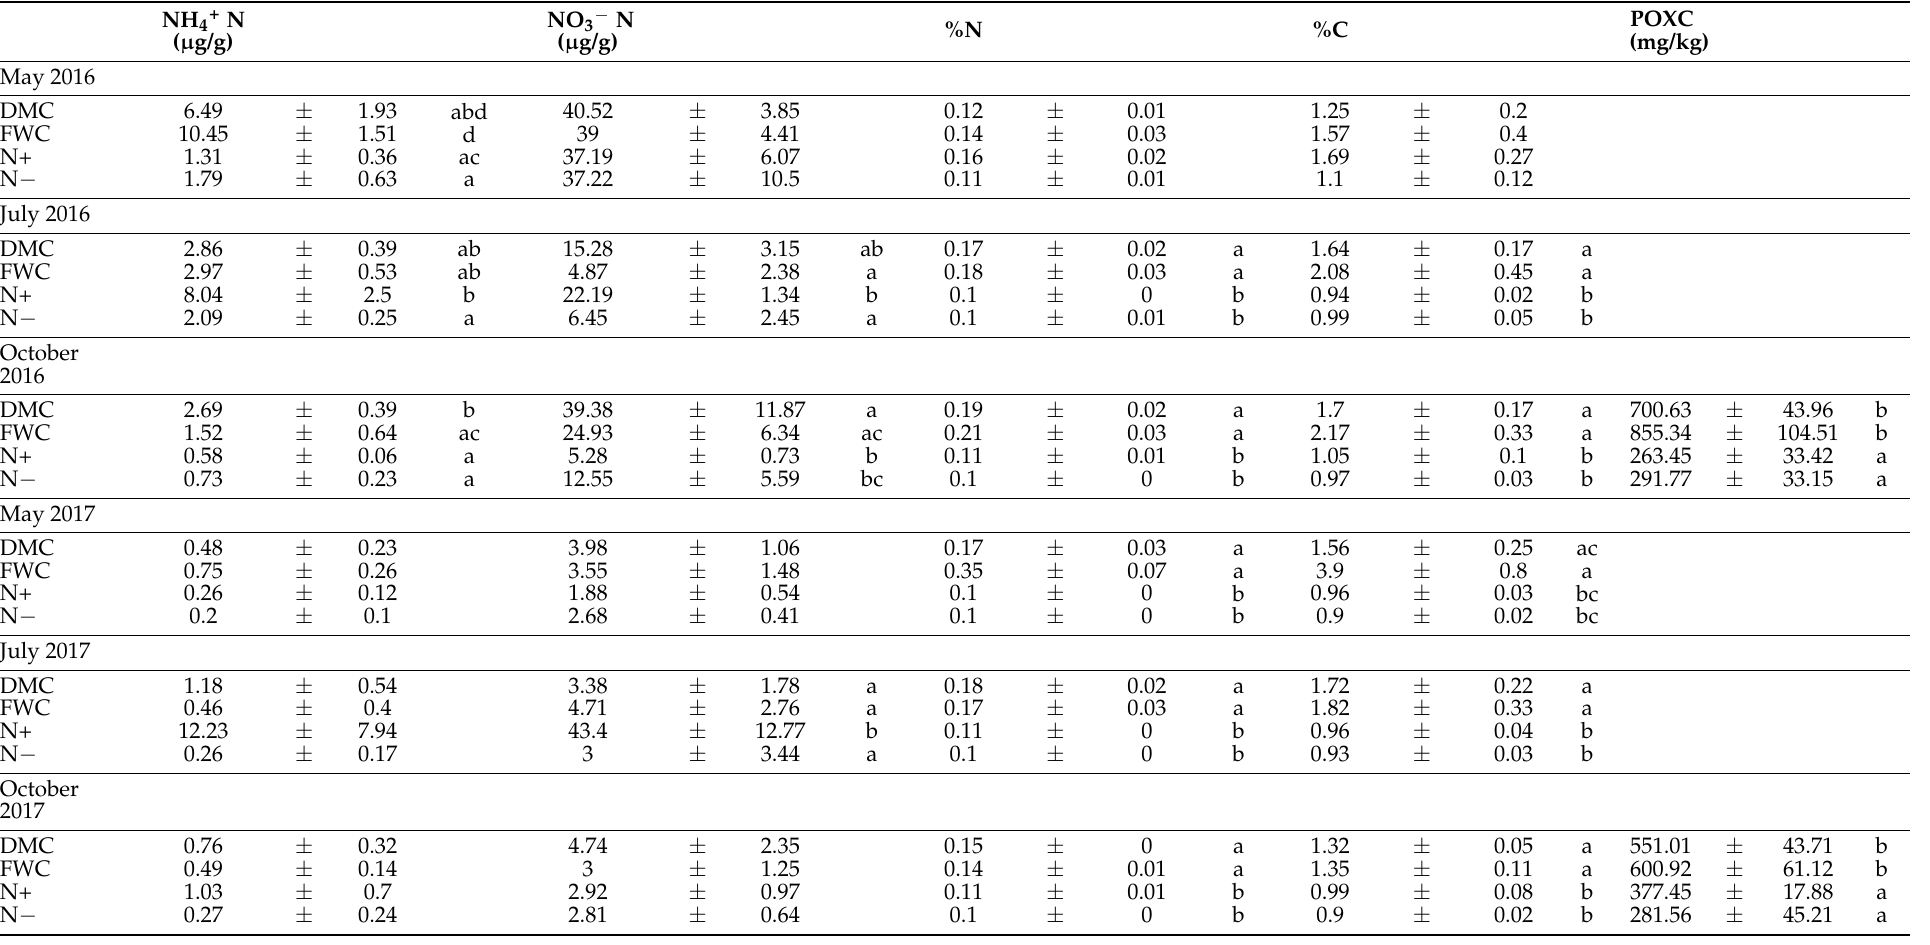
Table 1. Average soil properties ± standard error of measurement (SEM) from an almond orchard receiving different organic amendments. Letters denote statistical differences of p < 0.05 determined by either post hoc Tukey’s honestly significant difference (HSD) test or Dunn’s test, for non-normally distributed data. DMC = Dairy manure compost, FWC = Food